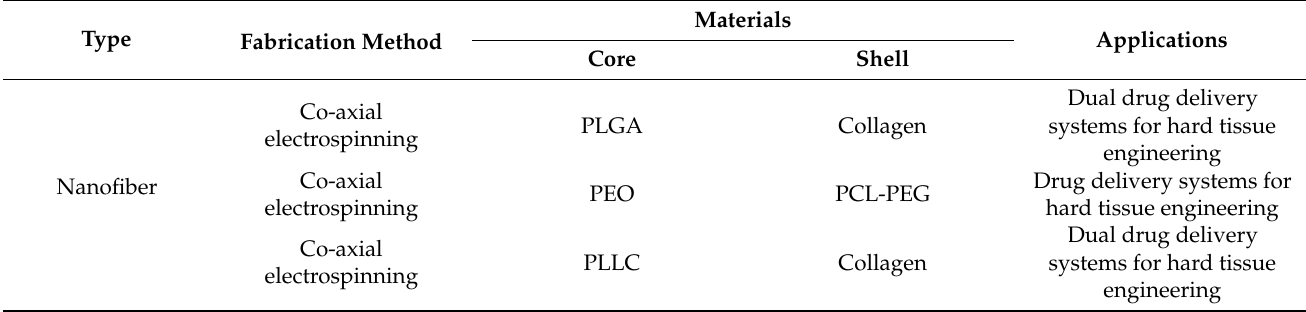
Figure 37. Scientometric bio-informatic mapping of anti-inflammatory drug delivery of biodegradable and natural polymeric biomaterials in hard tissue engineering. Table 3. Examples of systems used in hard tissue engineering [360].